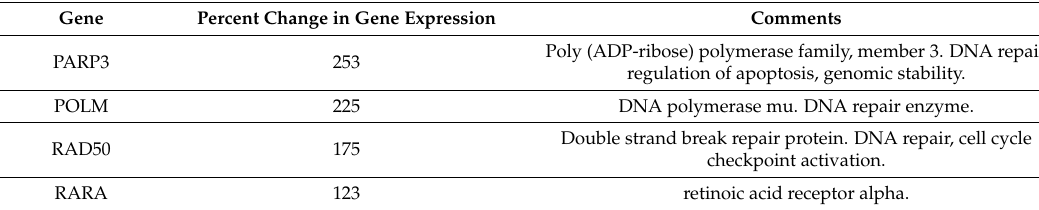
Table 5. Most Affected DNA Repair